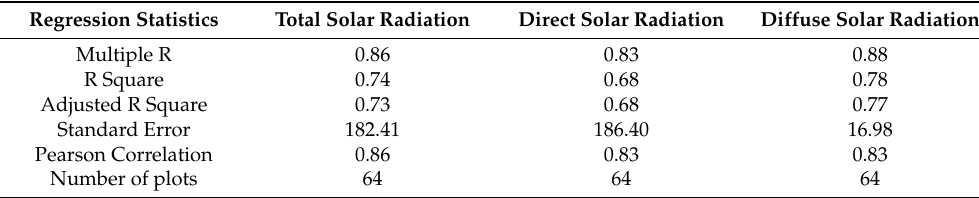
Multiple R is the square root of R-squared and this correlation coefficient shows how strong the linear relationship is. The adjusted R-squared is a modified version of R-squared that has been adjusted for the number of inputs in the model and compares the explanatory power of regression models that contain different numbers of predictors.